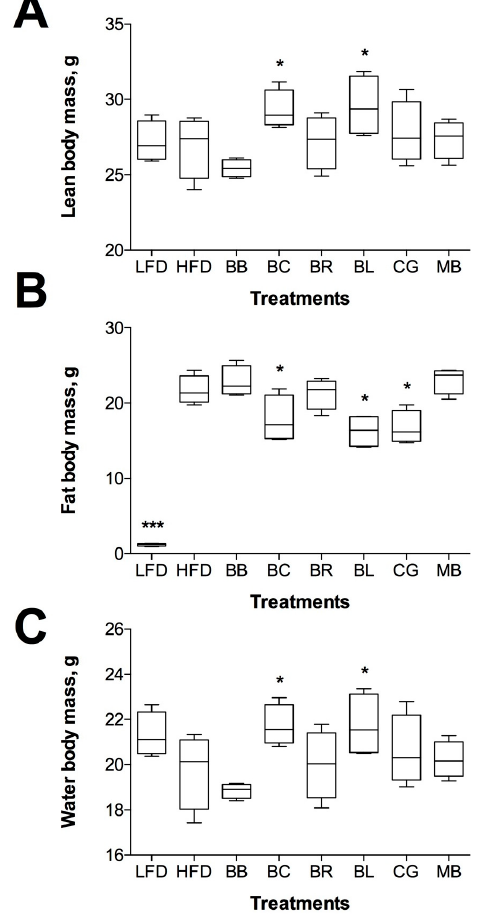
Figure 3. Effects of berry supplementation on body composition: ( A ) lean body mass; ( B ) fat body mass; and ( C ) total water are reported as means ± SEM. * p < 0.05 and *** p < 0.001 when compared to HFD by one-way ANOVA followed by Dunnett’s post hoc test.